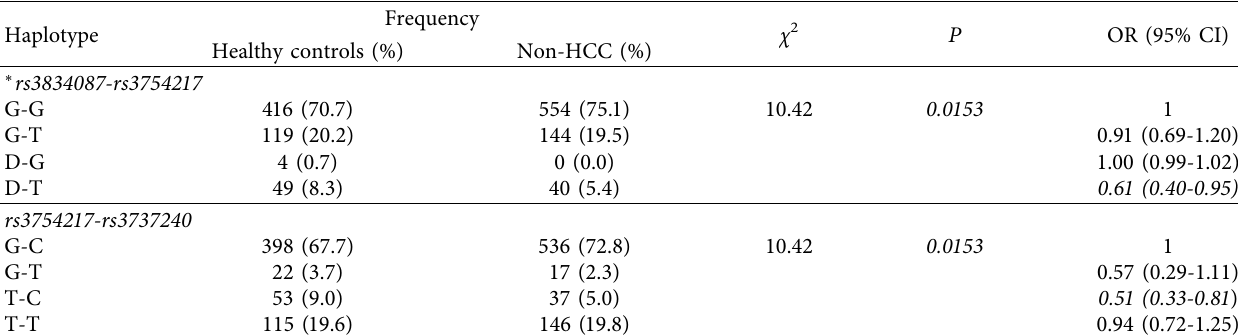
Table 7: Haplotype distributions between healthy controls and non-HCC patients.